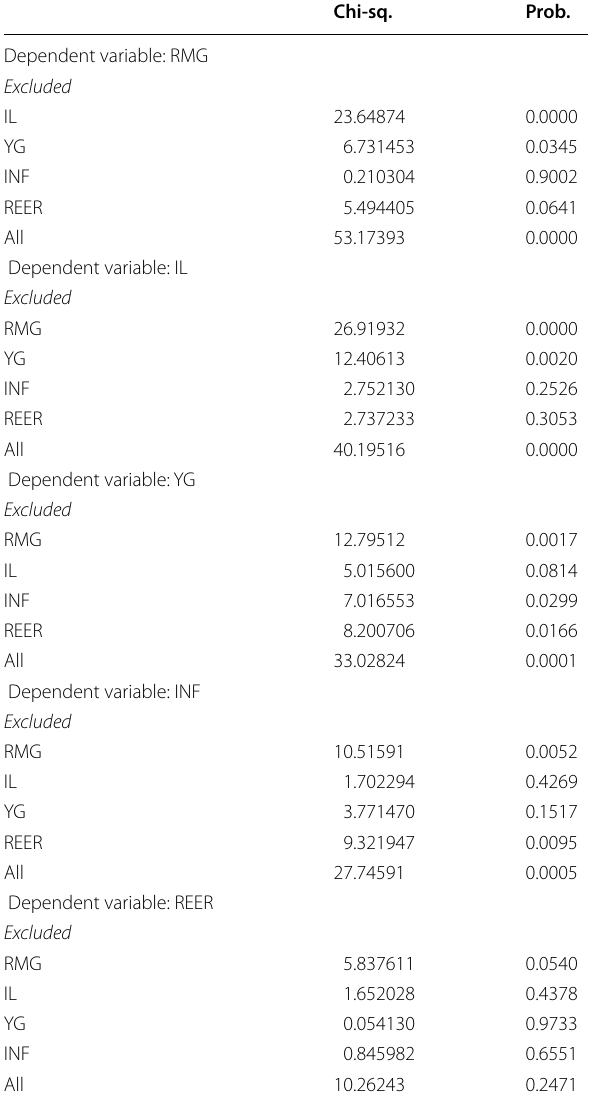
Table 3 VAR granger causality/block exogeneity Wald tests,